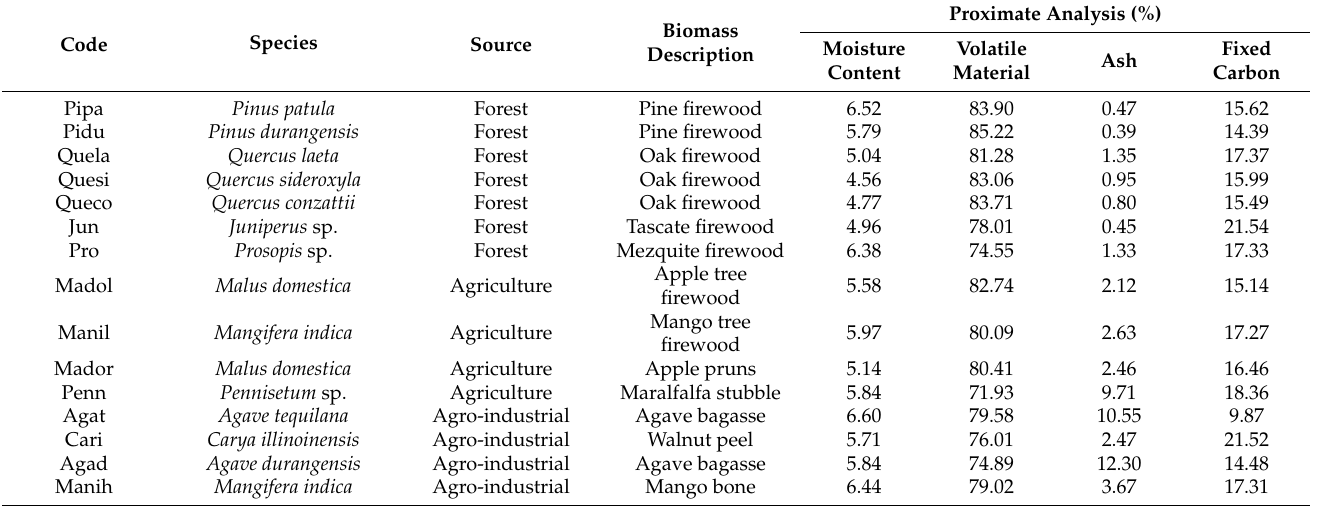
Table 1. Description of 15 different pellet base materials and their proximate